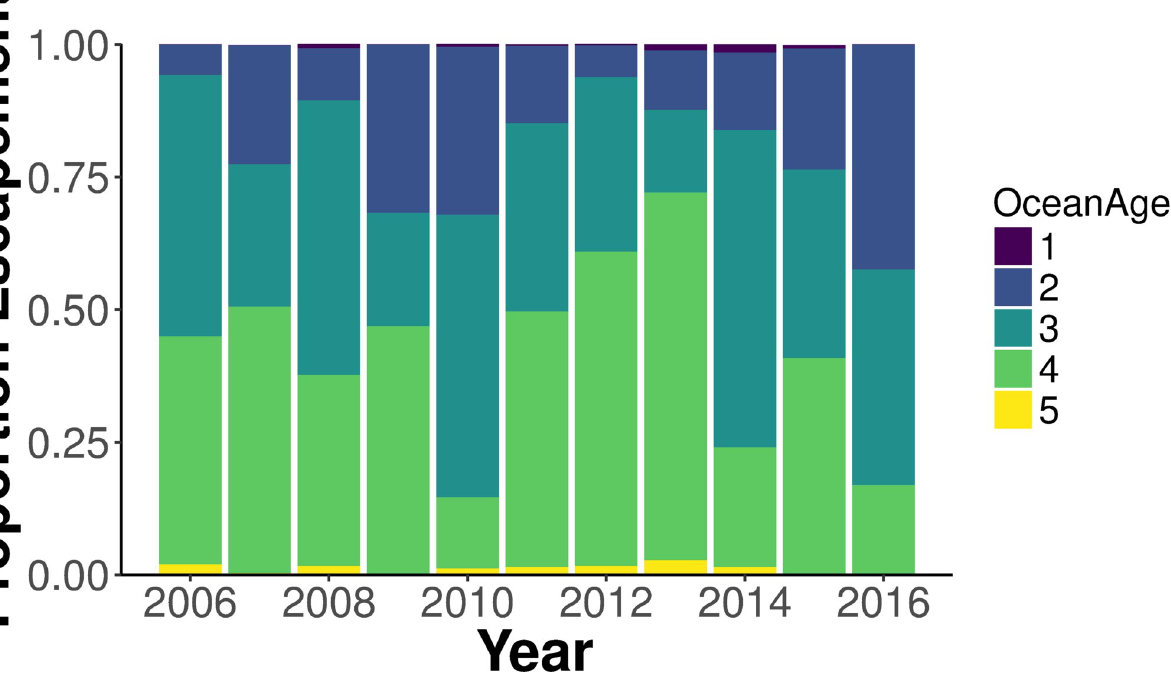
PLOS ONE | https://doi.org/10.1371/journal.pone.0247370 February 19,